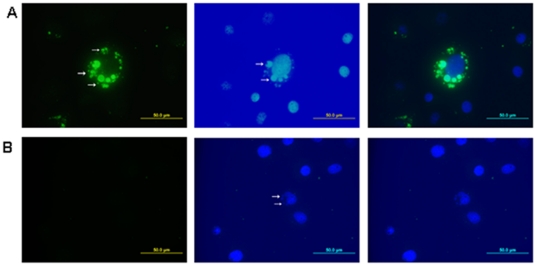
Detection of E. muris by fluorescence microscopy.(A) Antibodies produced against peptide P28-19 55–75 detected E. muris in infected DH82 cells. Left: Infected DH82 cell probed with P28-19 antibody, followed by FITC conjugated goat anti-mouse antibody. Middle: DAPI staining. Right: Merge. Arrows indicate E. muris. (B) Naïve serum did not detect E. muris in DH82 cells. Left: Infected DH82 cell probed with naive serum, followed by FITC-conjugated goat anti-mouse antibody. Middle: DAPI staining. Right: Merge. Arrows indicate E. muris.